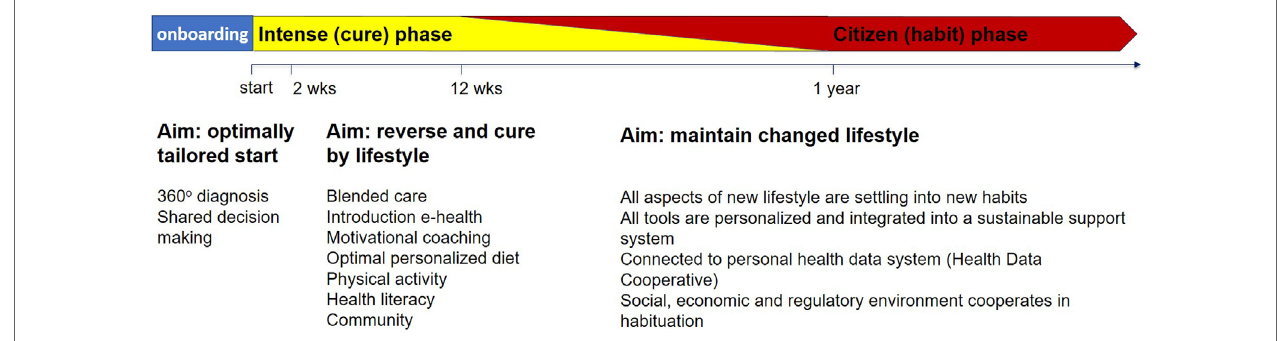
FiGURe 2 | Schematic representation of a personal cure and maintenance trajectory. Depending on the personal 360° diagnosis, the duration and intensity of the cure and maintenance phases and the relative contribution of the components may